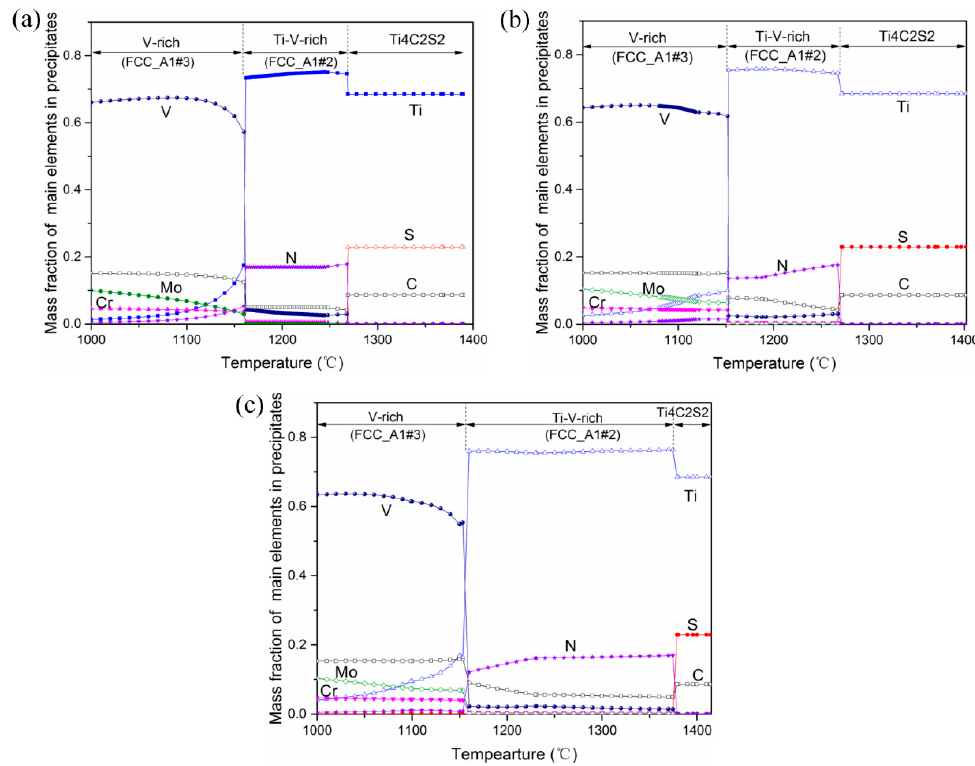
Figure 14. Mass fractions of the main elements in the primary carbides. ( a ) Ti-1 sample; ( b ) Ti-2 sample; ( c ) Ti-3 sample. Table 2. Precipitation temperature of the phases, ◦